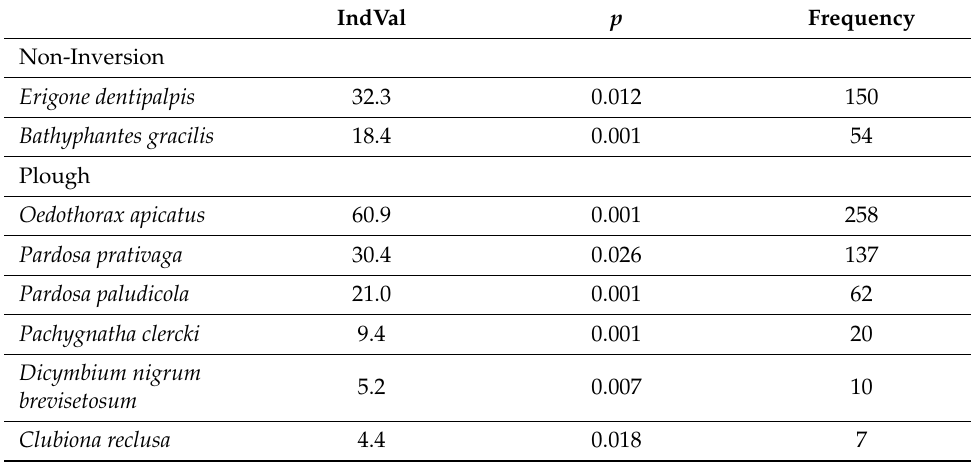
Figure 4. Diagram of the RDA demonstrating the relationships between the analysed environmental variables (type of tillage, cereal) and the ecological groups of spiders (agrobionts, cursorial, web). The first ordination axis, describing 90.8% of the variance, was strongly correlated with the presence of agrobiontic epigeic hunters, i.e., cursorial species, which occur most often in ploughed fields. The presence of web-building spiders was more strongly correlated with the kind of cereal grown, as they most willingly appeared in triticale fields. The IndVal method indicated that two species of spiders, E . dentipalpis and B. gracilis were characteristic for non-inversion soil tillage, while a set of six species of spiders, with dominant O. apicatus , proved to be characteristic for ploughed fields (Table 5). Table 5. Values of IndVal indicator of the spider species significantly characteristic ( p < 0.05) for the type of soil cultivation in cereal